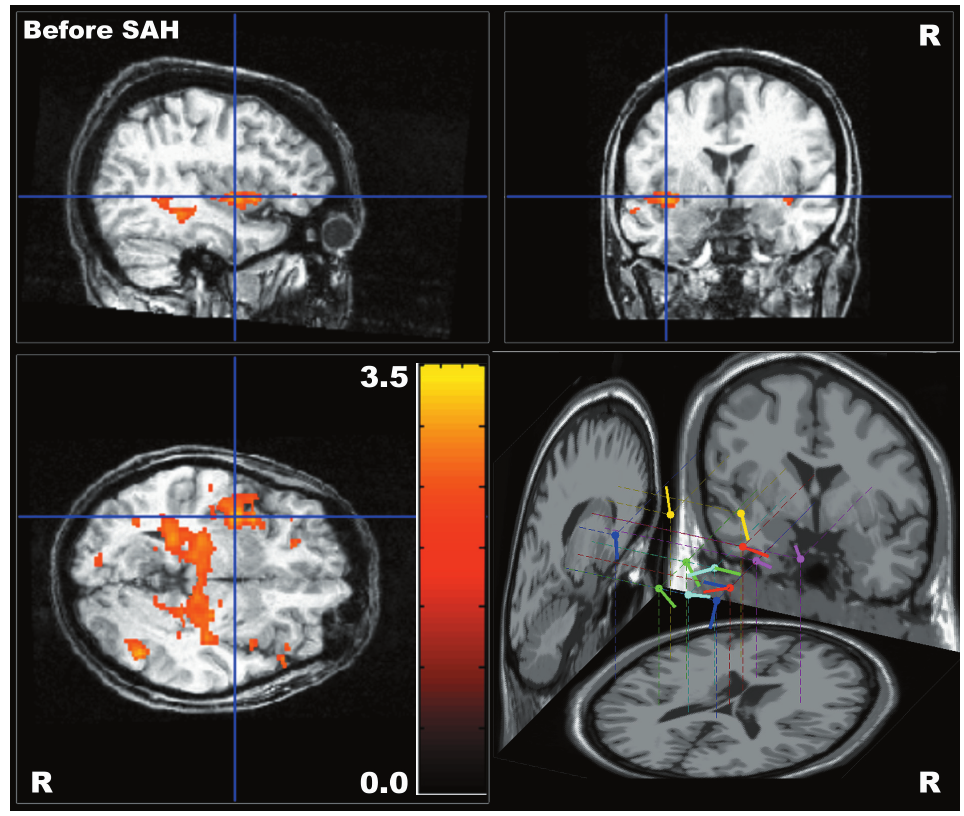
Figure 1. Blood oxygen level-dependent (BOLD) contrast activation responses associated with all interictal epileptiform discharges recorded before selective amygdalohippocampectomy (SAH) and coregistered to the patient’s brain structural magnetic resonance imaging. The color bar indicates T-values for positive BOLD responses. In the right lower view of this figure, dipoles to independent component analysis (ICA) are shown in the Montreal Neurological Institute standard brain, with left-sided predominance. Each dipole color indicates an individual ICA